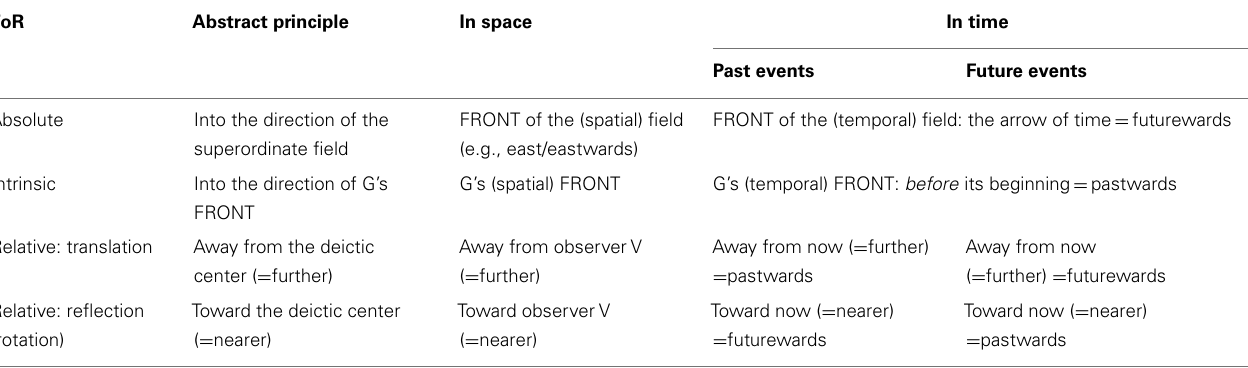
Table 1 | Direction of “forward” in dynamic settings depending on the FoRs in space and time (with G referring to the ground object). FoR